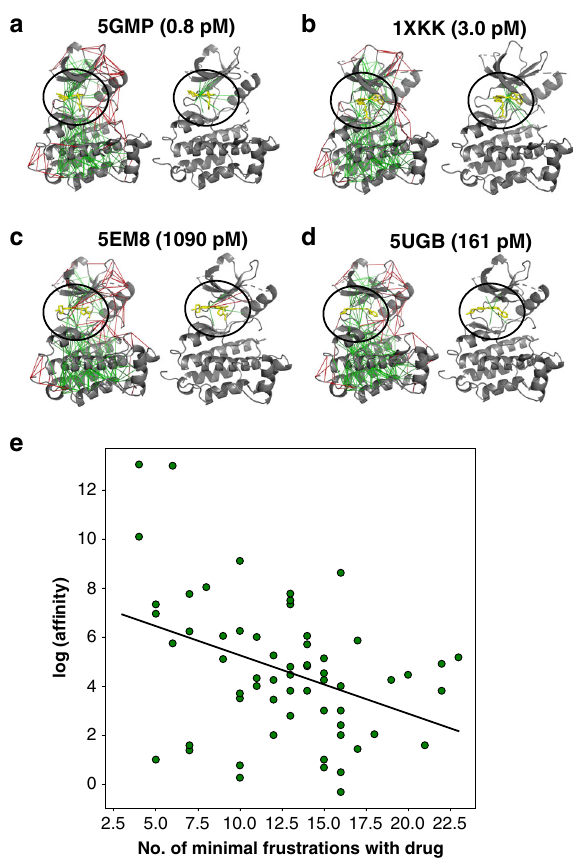
Fig. 5 Examples of localized frustration patterns in EGFR-inhibitor complexes. For each binding complex in ( a – d ), the frustration indices are shown as calculated and shown on the left panel, and frustrations around the ligands only are shown on the right panel. e The correlation between the number of minimally frustrated interactions in each EGFR-inhibitor complex and the logarithm of binding af fi nity in the picomolar unit at a base of 2 is shown. A regression line is plotted to illustrated the trends with a modest pearson correlation of